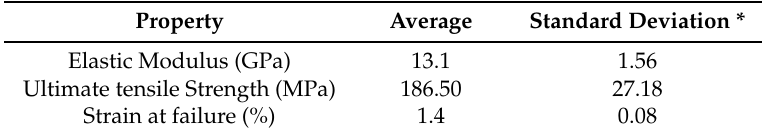
Table 1. Summary of average mechanical properties of the SDOF composites.